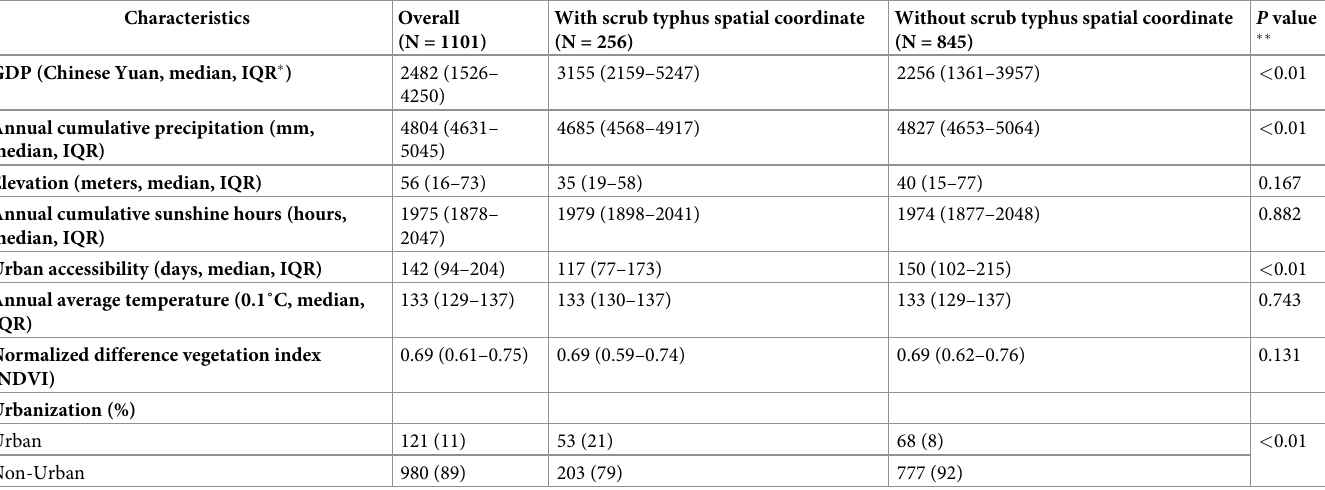
Table 1. Characteristics of environmental and socioeconomic covariates for overall, with and without scrub typhus spatial coordinate. Characteristics